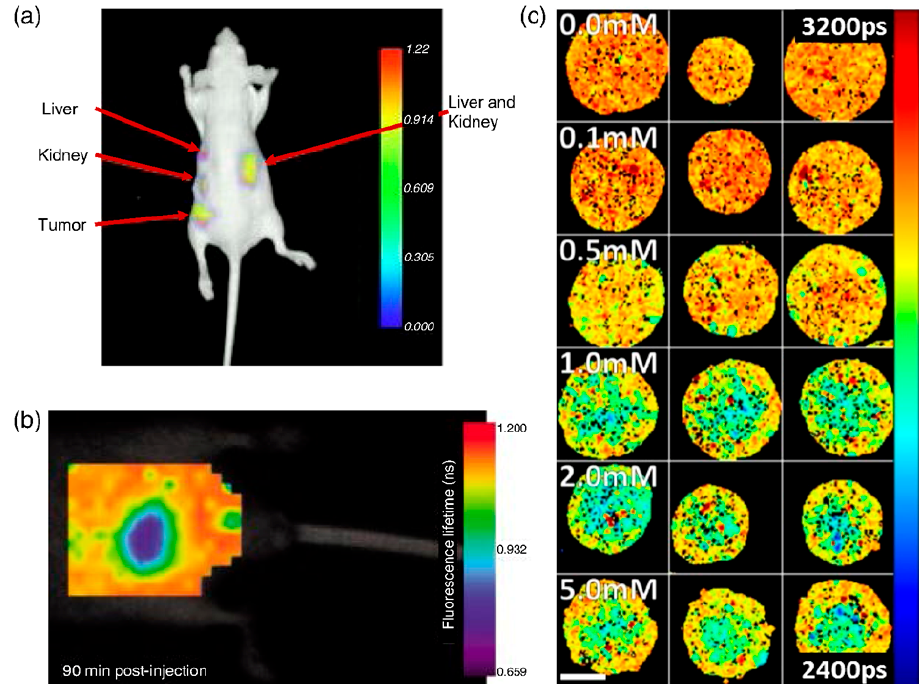
Figure 3. Fluorescence lifetime of mouse. The fluorescence lifetime image of A549-tumor in mouse and fluorescence lifetime of mouse after intravenous injection of LS-288 with the maps of the weighted mean fluorescence lifetime. ( a ) Fluorescence lifetime image of Cyp-GRD distributionat 24-h postinjection. ( b ) Fluorescence lifetime (heatmap) of mouse abdomen acquired 90 min after intravenous injection of LS-288. ( c ) FLIM maps of the weighted mean fluorescence lifetime. Reprinted with permission from reference [25], 2020, Datta et al., doi:10.1117/1.JBO.25.7.071203.